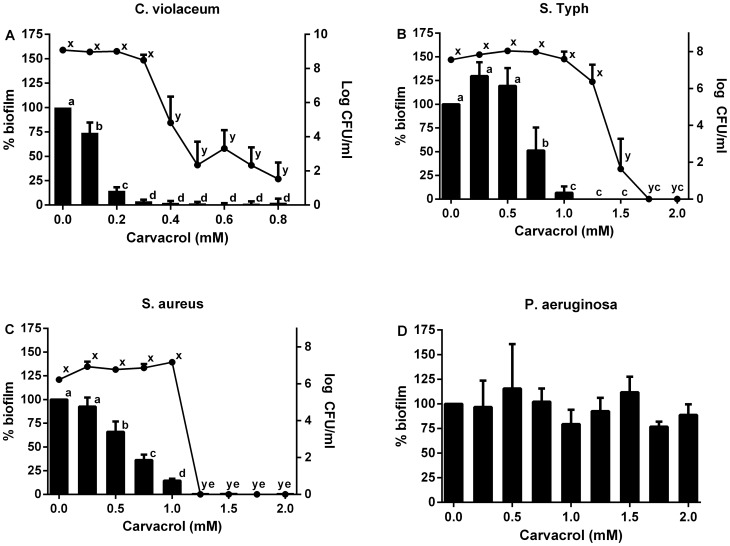
(A–D). Carvacrol reduces biofilm formation by C. violaceum, S. Typhimurium and S. aureus but not P. aeruginosa.Percentage biofilm formation measured as OD (590 nm) after crystal violet staining after 24 h incubation in the presence or absence of carvacrol (0–0.8 mM) (bars, left axis) compared to colony counts (log cfu/ml) from the same samples (connected dots, right axis). C. violaceum (A), S. Typhimurium (B), S. aureus (C), P. aeruginosa (D). Data points which are significantly different from each other are denoted by different letters (p<0.05). Bars indicate standard error of the mean.